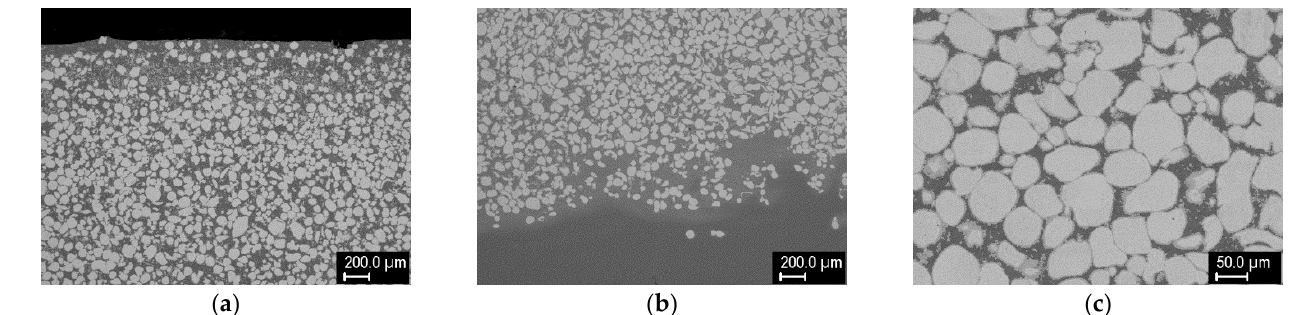
Figure 4. Cross sections of W–Ni cladding made from 95% W mixture: ( a ) overview near the top, ( b ) overview near the substrate, ( c ) detail from the middle of the cladding.